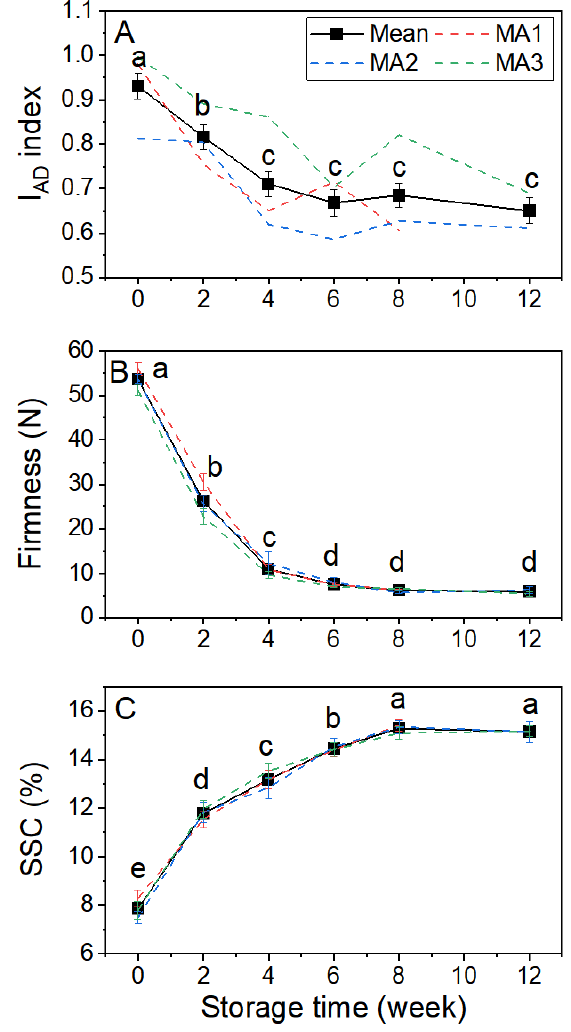
Figure 4. The change in I AD index ( A ), firmness ( B ), and soluble solids content (SSC, ( C )) of Actinidia chinensis var. chinensis ‘Donghong’ fruit during storage at 1 °C for 12 weeks. Bold lines and symbols are the mean of three maturity areas ( ± s.e.m.), dashed lines the individual maturity areas (MA) for which n = 60 at harvest and 45 at other times. Values not sharing a common letter differ at p = 0.05.